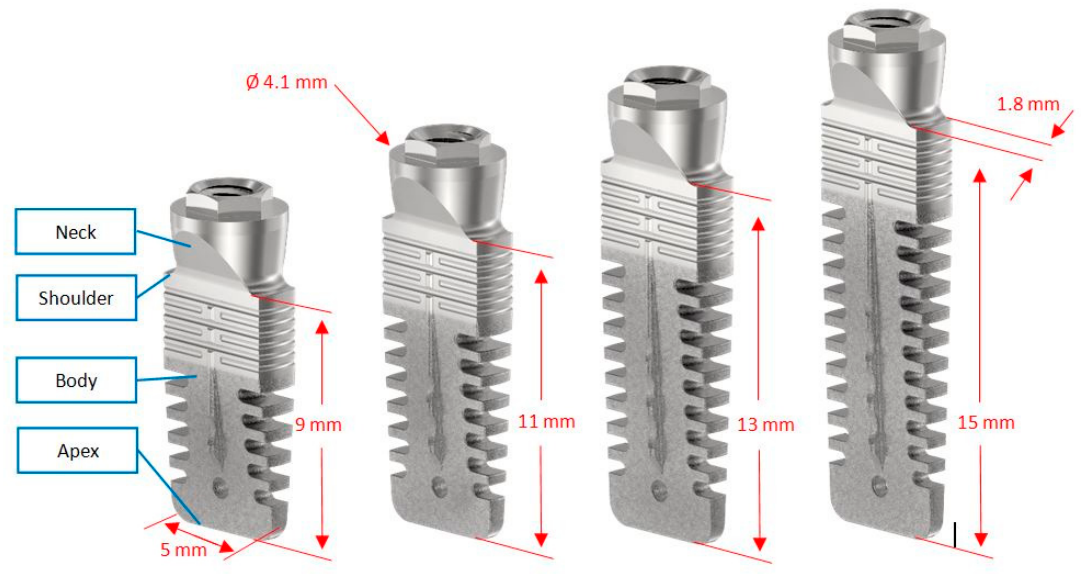
Figure 1. Device investigated: a tissue level, wedge-shaped dental implant with an external connection and four different lengths.